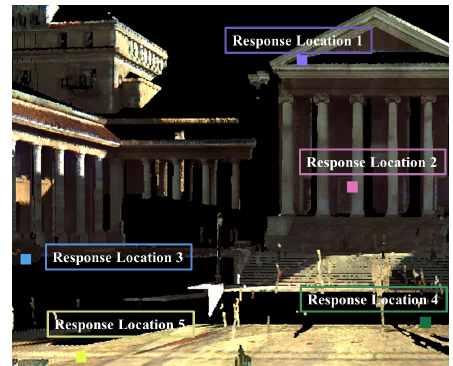
Figure 9: A point cloud with randomly chosen nodes made re- sponse locations. The octree is omitted in this